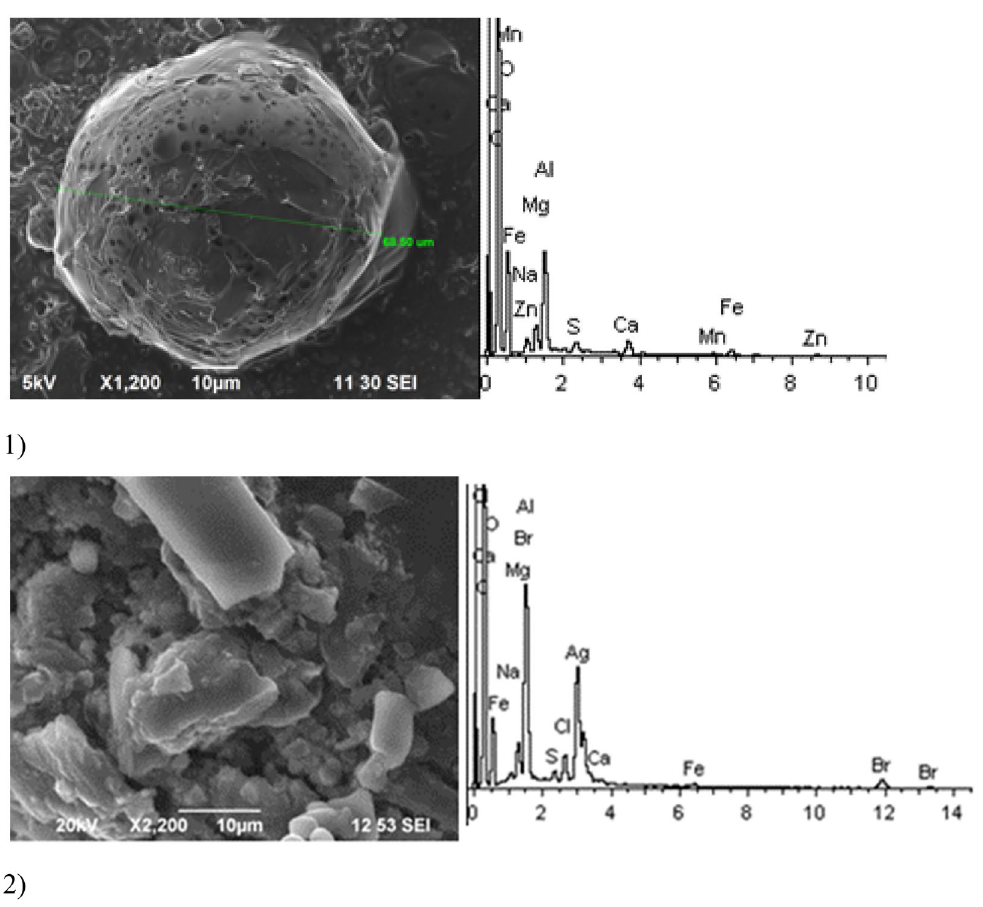
Figure 4. Aluminum cleaning. Particles morphology. Scanning electronic microscopy. 1) Magnification ×1,200, 2) Magnification ×2,200.